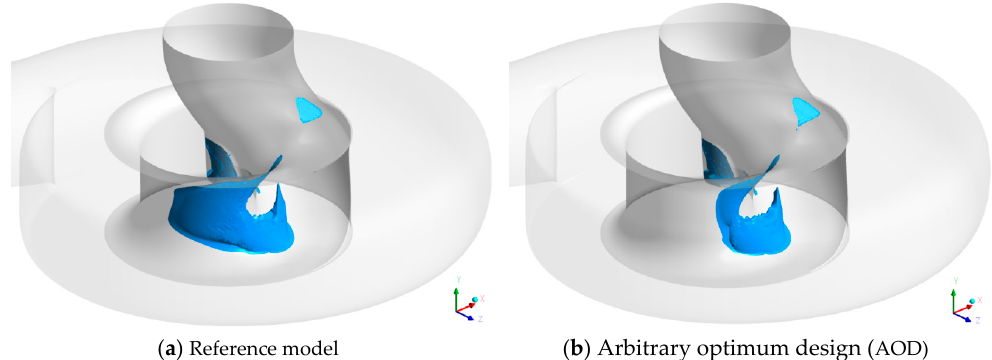
Figure 12. Time-averaged iso-surfaced contours at a low velocity of 1.5 m/s.